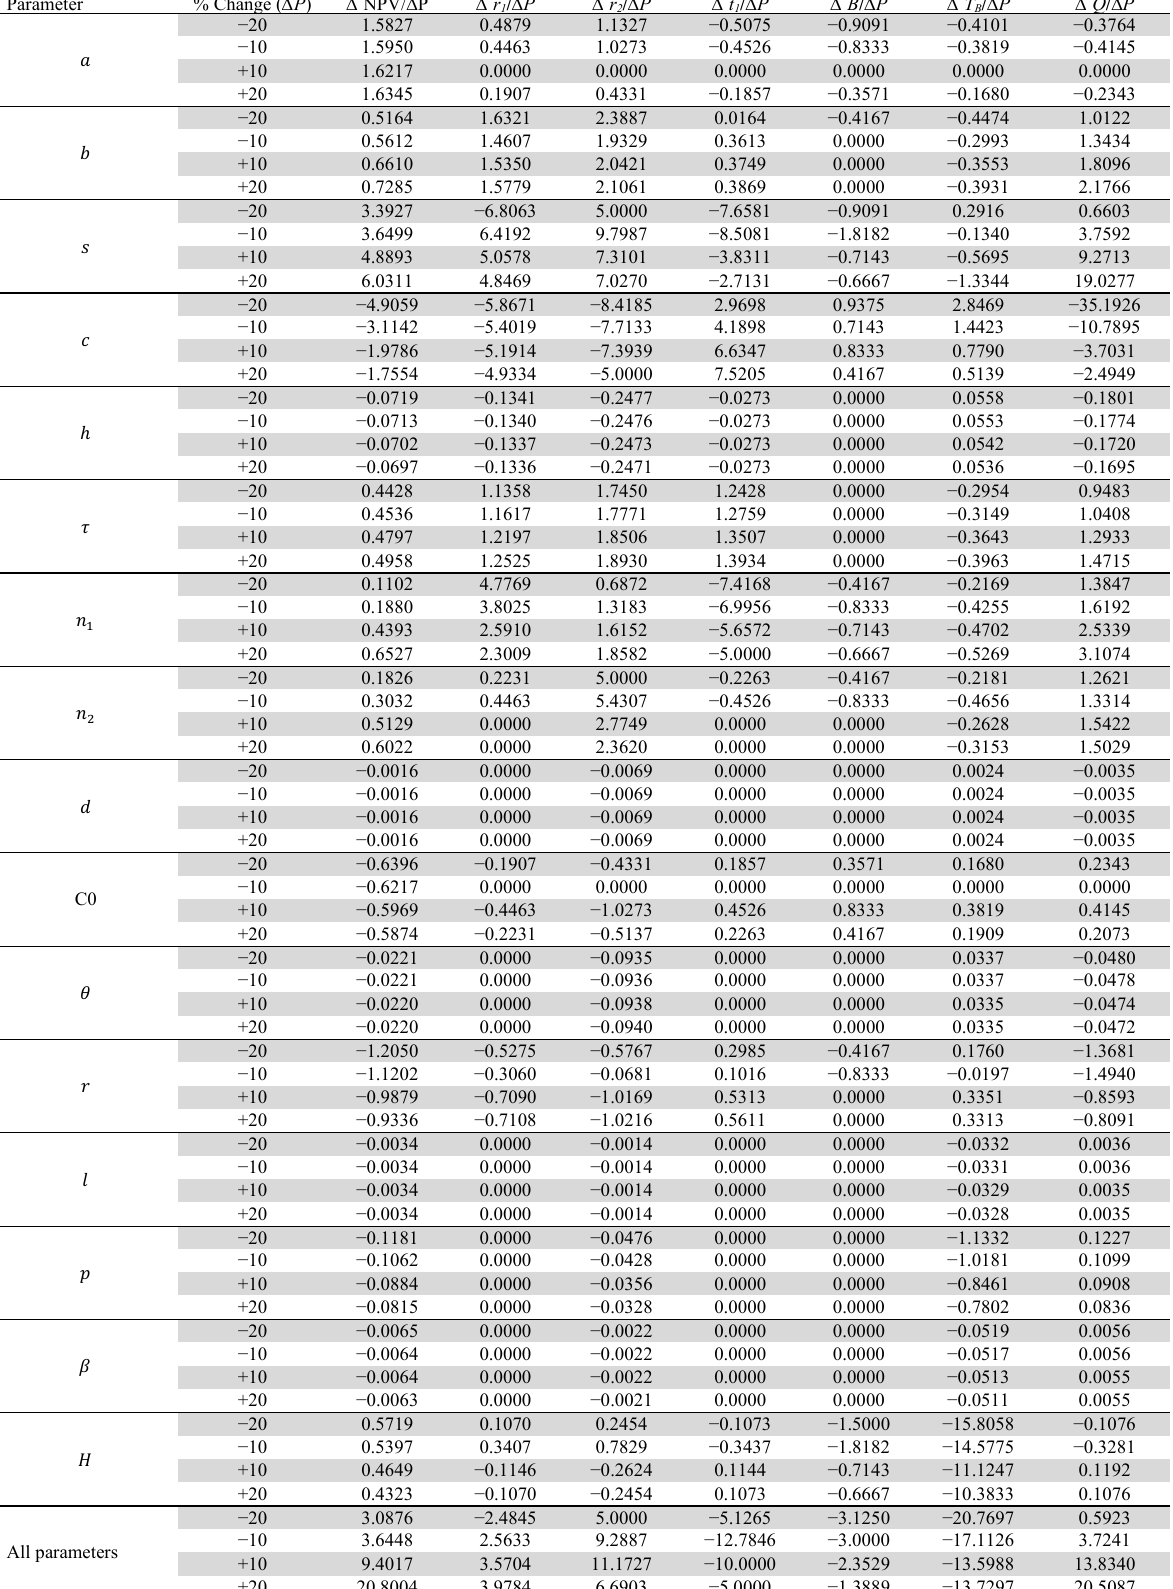
Sensitivity analysis of the model with pre- and post-deterioration discount